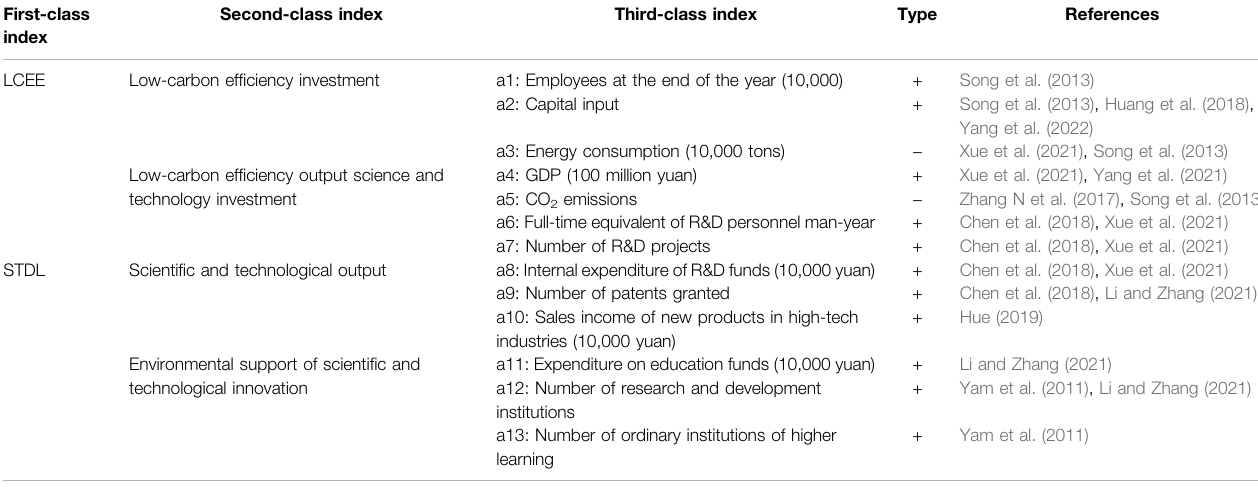
TABLE 1 | Index system of LCEE and the STDL.